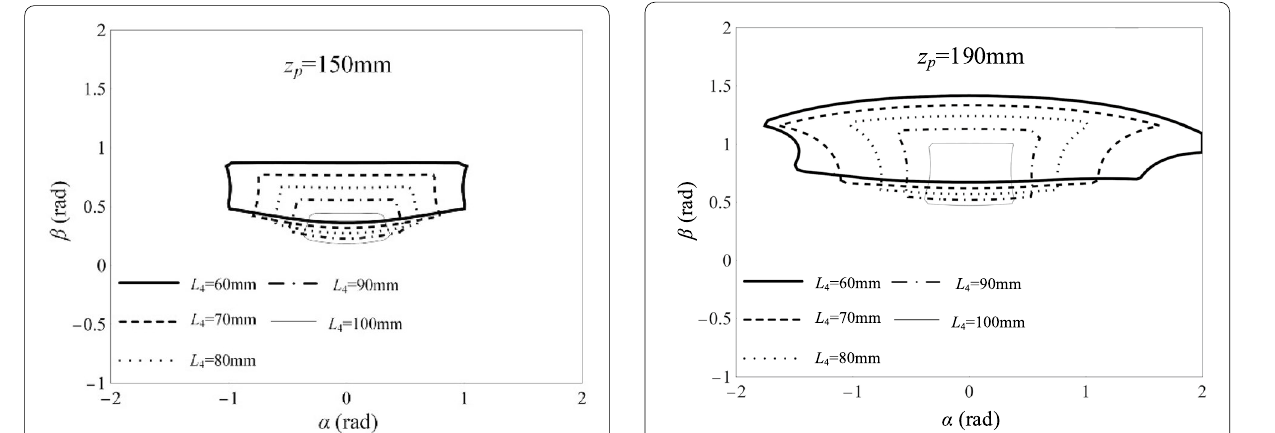
Figure 17 The image of the singular position of the mechanism when z p 190 =